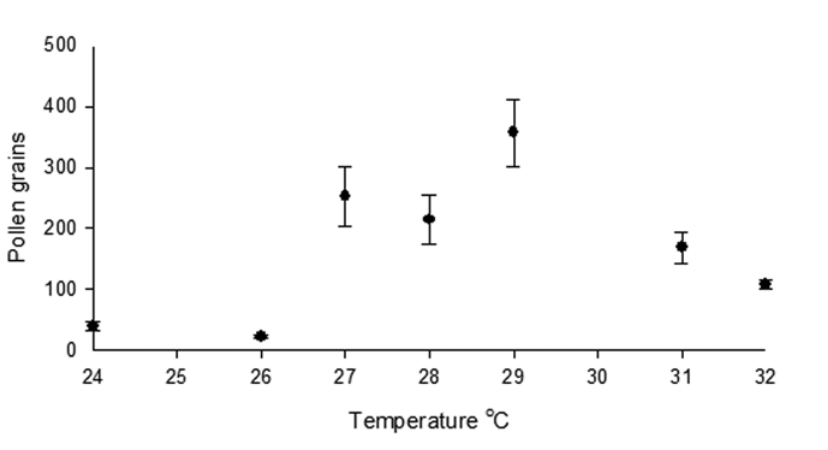
Fig. 4. Pollen grains collected in function of temperature in an Amazonian Rain Forest fragment in Sorriso, Mato –